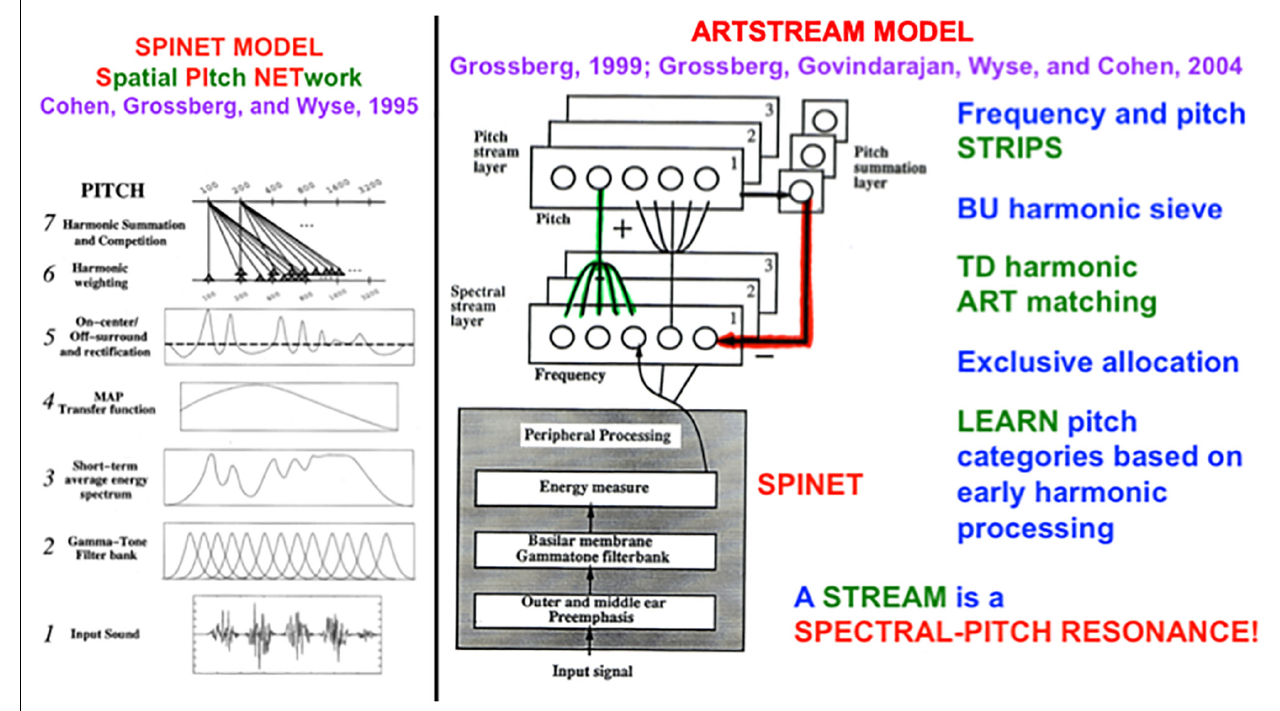
FIGURE 2 | (left panel) The Spatial Pitch Network, or SPINET, model (Cohen et al., 1995) shows how a log polar spatial representation of the sound frequency spectrum can be derived from auditory signals occurring in time. This spatial representation allows the ARTSTREAM model to compute spatially distinct auditory streams. (right panel) The ARTSTREAM model explains and simulates the auditory continuity illusion as an example of a spectral-pitch resonance. Interactions of the ART Matching Rule and asymmetric competition mechanisms in cortical strip maps explain how the tone selects the consistent frequency from the noise in its own stream while separating the rest of the noise into another stream. [Reprinted with permission from Grossberg et al.